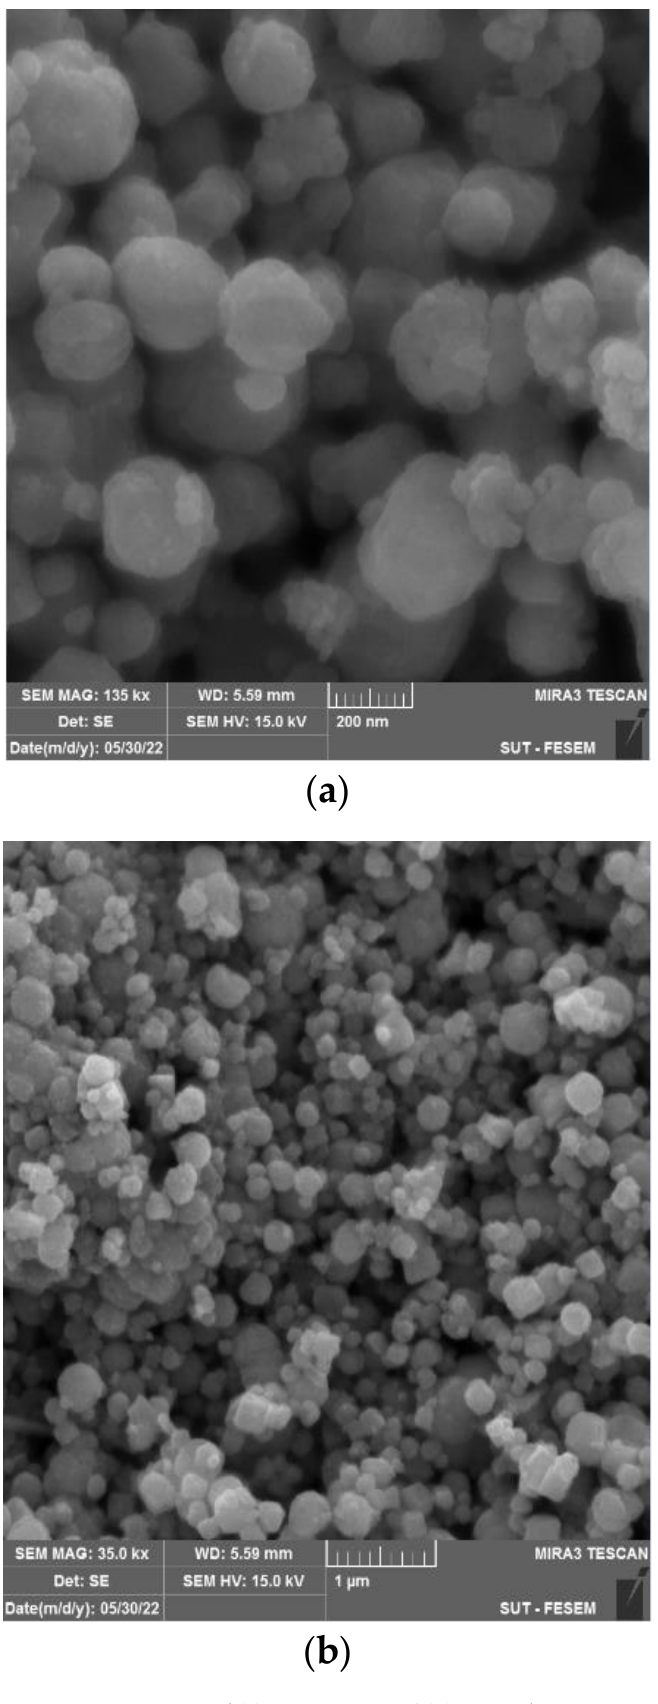
Figure 4. SEM images of ( a ) Fe 3 O 4 NPs and ( b ) Fe 3 O 4 /CA.